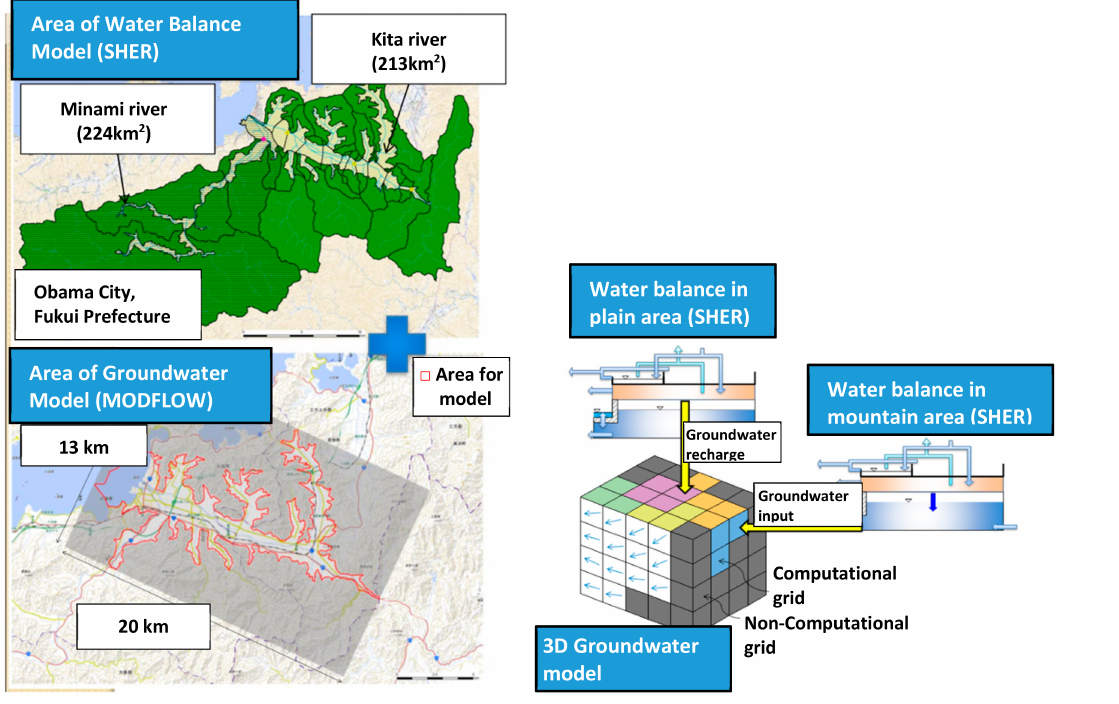
Figure 2. Model areas and interactions between the water balance (similar hydrologic element response (SHER)) and 3D groundwater (modular finite-difference groundwater flow (MODFLOW))